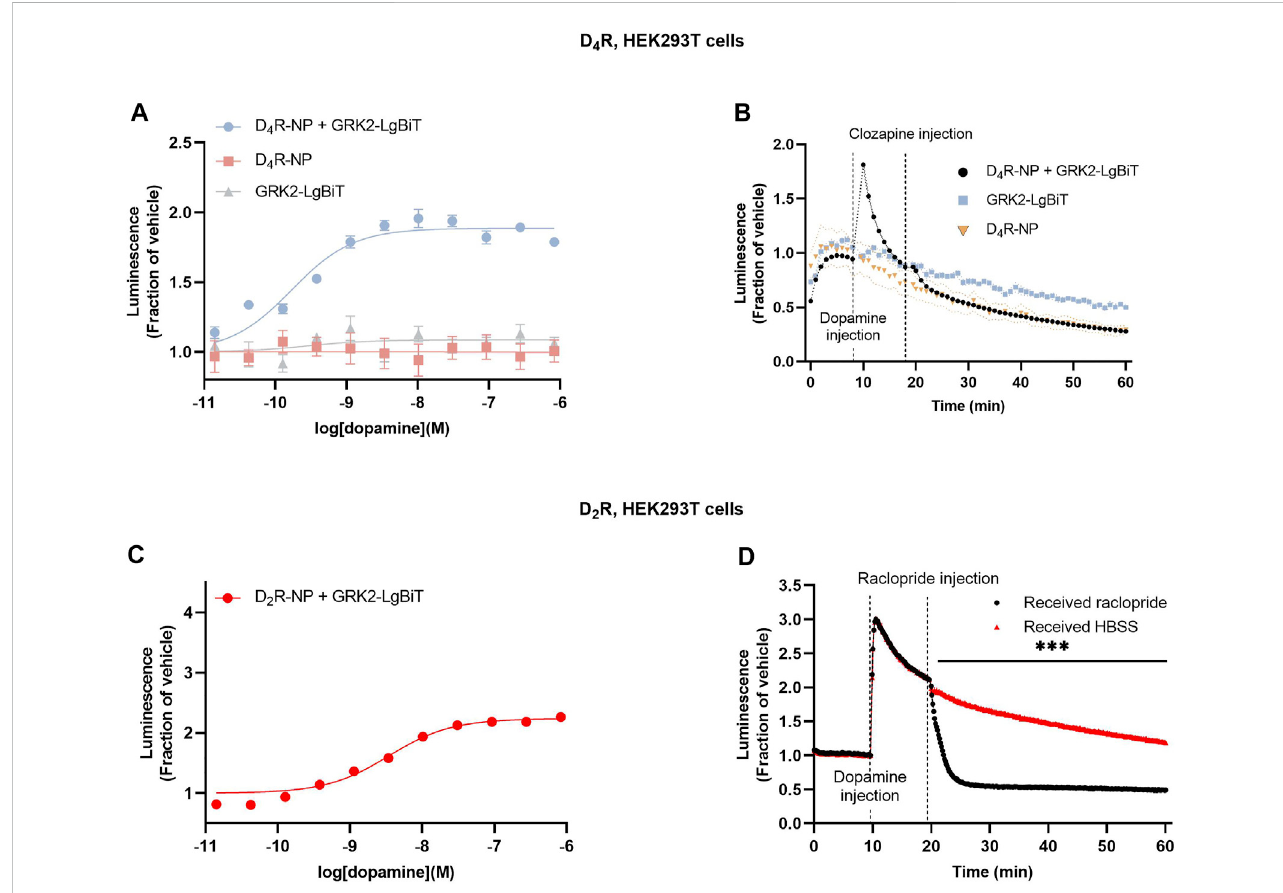
FIGURE 2 AssessmentofGRK2recruitmenttotheD 4 RandtheD 2 R. (A) Concentration-responserelationshipsfordopamine-induceluminescenceincreaseincells co-expressing D 4 R-NP with GRK2-LgBiT, or either construct expressed alone. Measurements were taken 3 min after the addition of dopamine. (B) Kinetic experimentsrevealed atransient increase indopamine-inducedluminescenceincells co-expressing D 4 R-NP withGRK2-LgBiT. (C) Concentration-response relationships for dopamine-induce luminescence increase in cells co-expressing D 2 R-NP with GRK2-LgBiT. Measurements were taken 3 min after the additionofdopamine. (D) Kineticexperimentsshowingthetime courseofthedopamine-induced luminescenceincreaseincellsco-expressingD 2 R-NPwith GRK2-LgBiTandtheblockadeoftheresponsetodopamineuponapplicationoftheD 2 Rantagonistraclopride.Asterisksandhorizontalbarindicateaninterval of statistically signi fi cant differences between the raclopride and HBSS control conditions. ***; p < 0.001, repeated measures ANOVA with Sidak ’ s multiple comparisons test. Luminescence data are expressedas fractionsof the signal observed in vehicle-treated wells (A, C) , or prior to dopamine application (B, D) . Datapointsrepresentmean±SEMfromeightreplicatewellsfromonerepresentativeexampleoutofthreeindependentexperiments.SEMbandsareshownin (B, D) . For some data points, SEM bars or bands are obscured by the symbols representing the